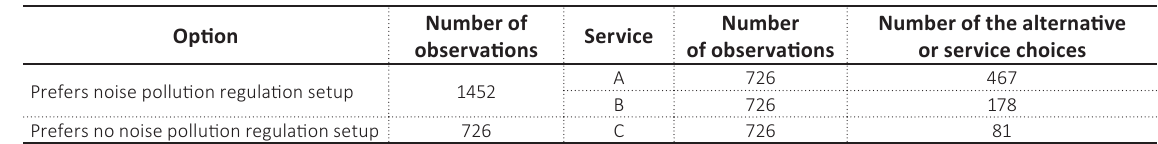
Table 3. Specified tree structure of the nested logit model: case of noise pollution regulation